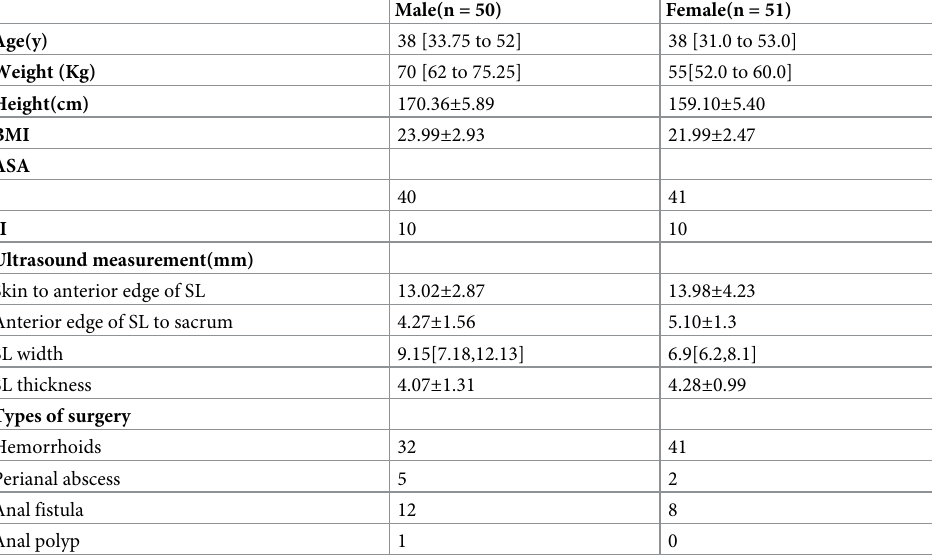
Table 1. Characteristics of patients.